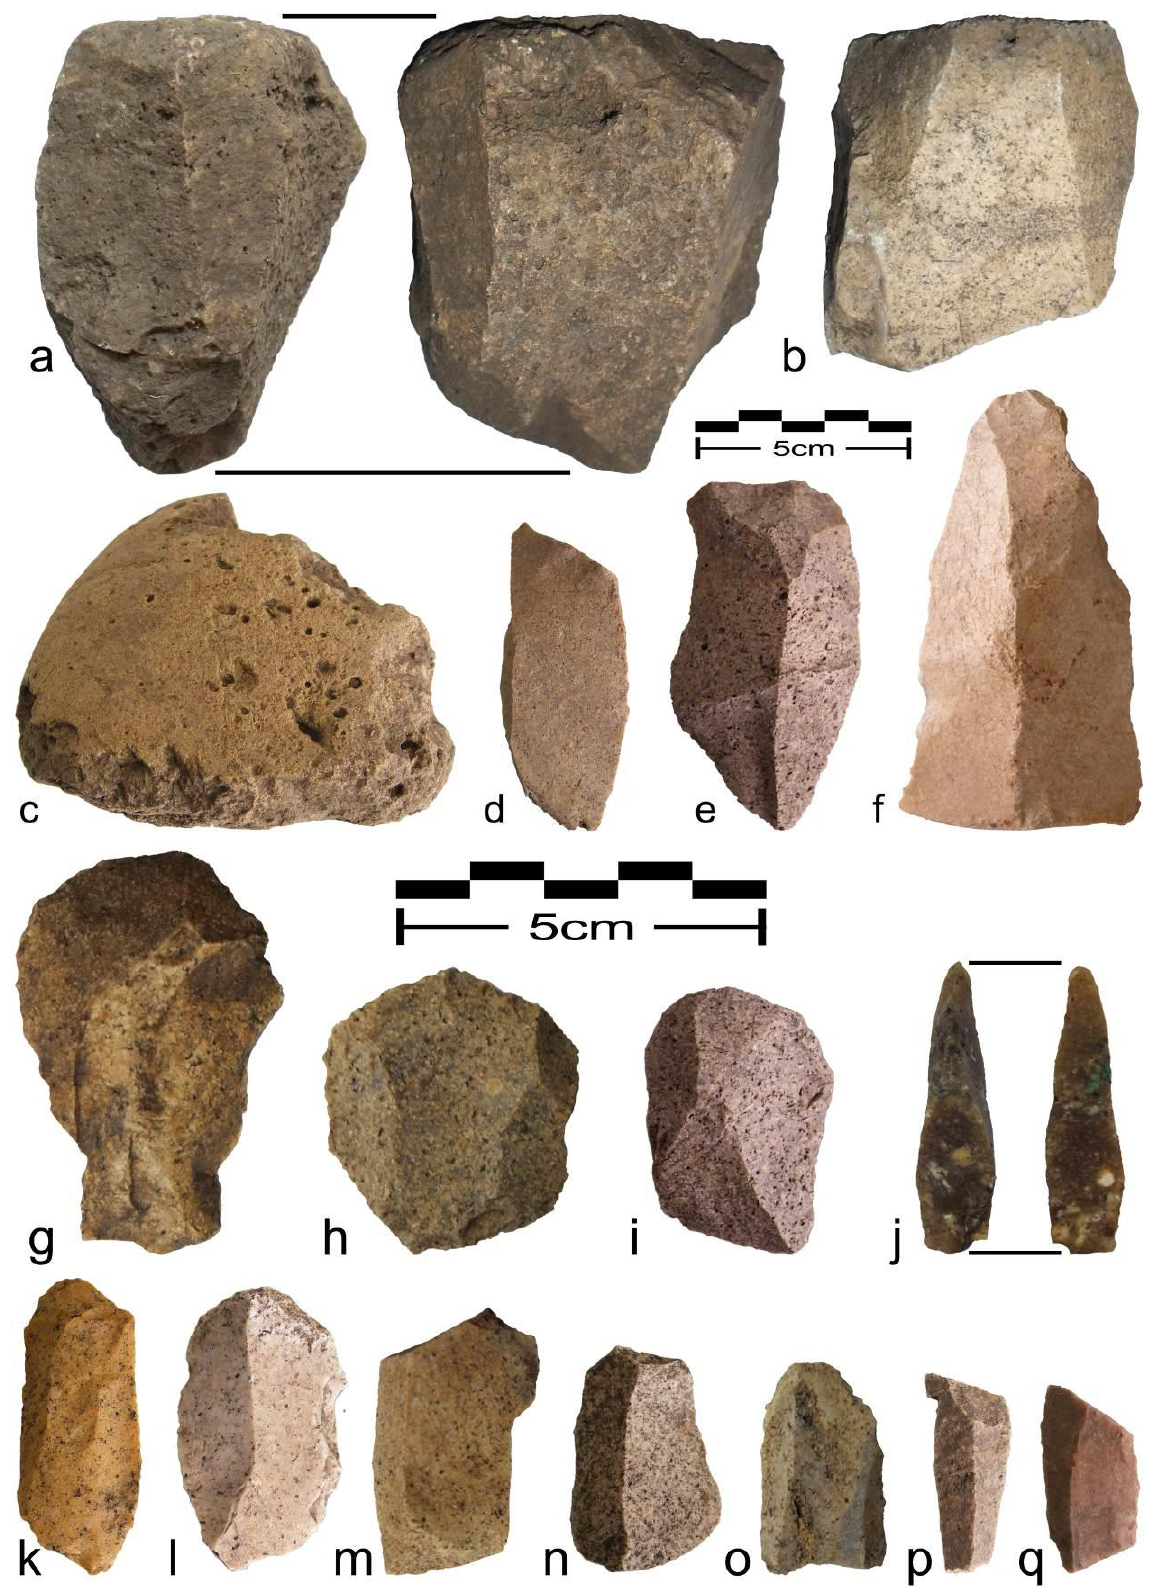
Figure 7. Examples of chert artefacts from the site. a) and b) cores; c) fragment of a hammer stone, pounding stone or grinding stone; d) to f) blades; g) to i) scrapers; j) a perforator; k) to q) blades or blade fragments. (Artefacts a to f are at the same scale as each other. Artefacts g to q are at the same scale as each